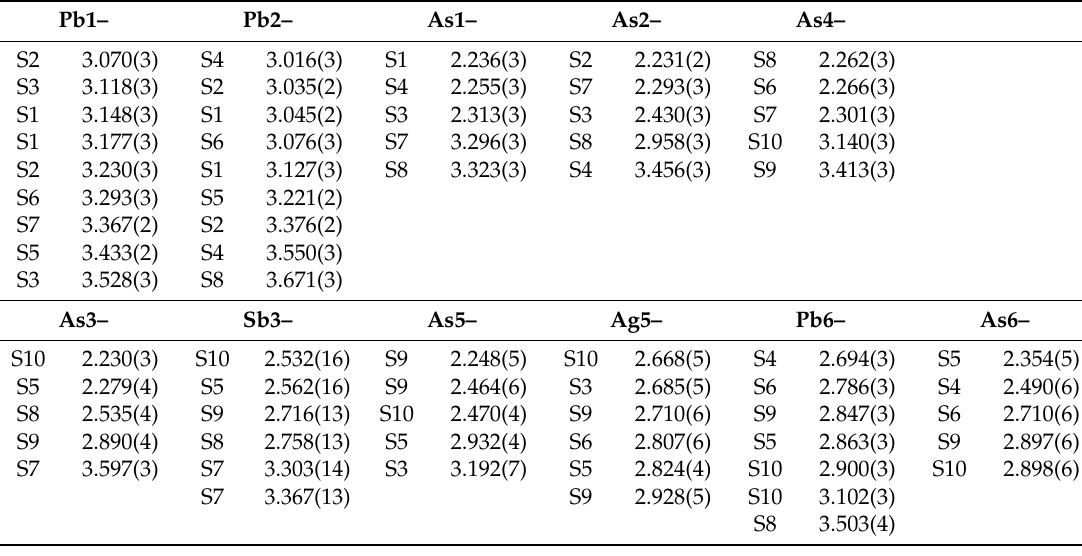
Table 10. Bond lengths in sample rath9 (Tl-richest sample, with 11.78 wt%